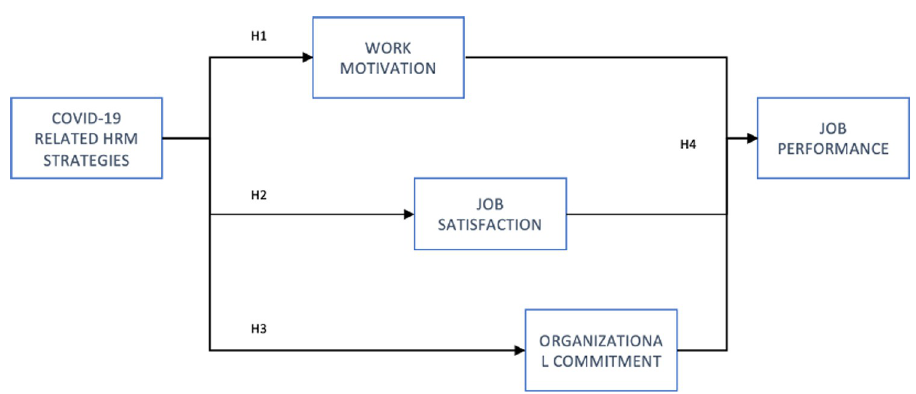
Fig 1. Hypotheses overview. Source: own work.